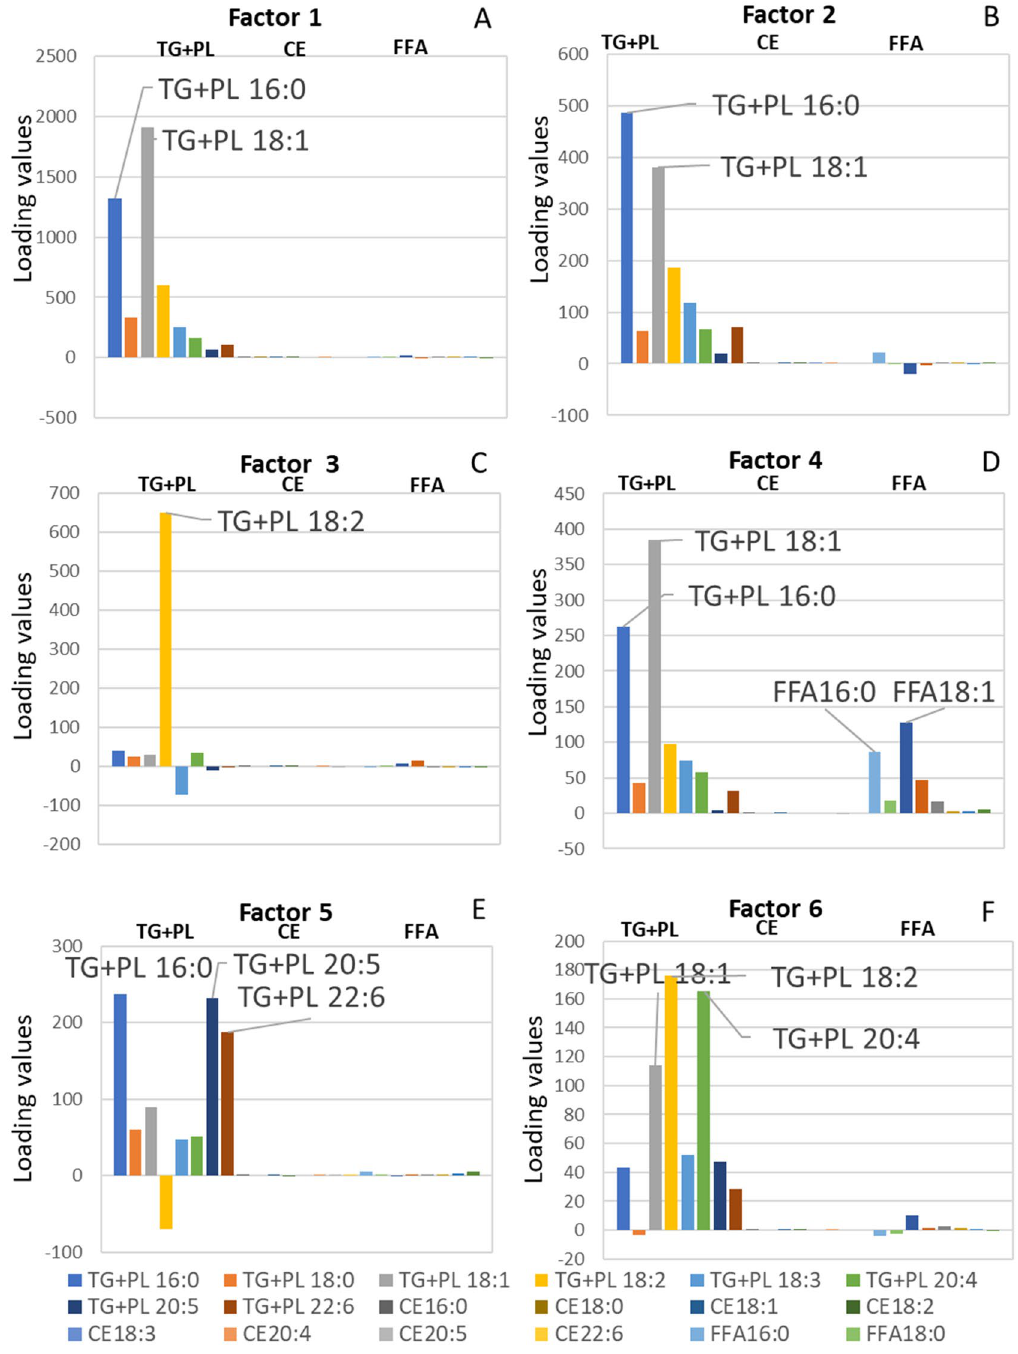
Figure 2. Histograms of factor analysis results, including ( A ) Factor 1, ( B ) Factor 2, ( C ) Factor 3, ( D ) Factor 4, ( E ) Factor 5, and ( F ) Factor